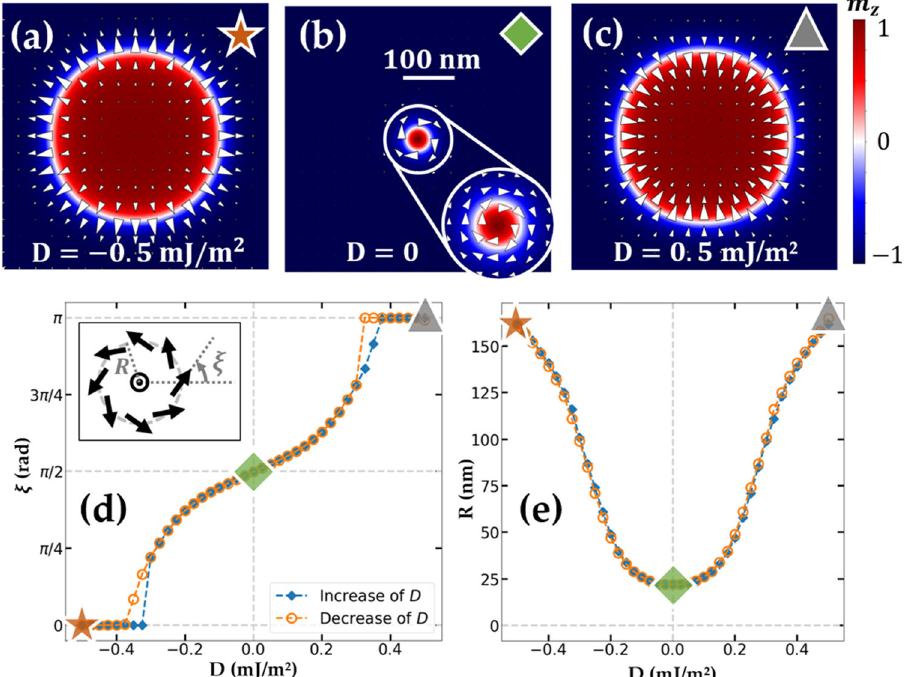
Fig. 4 | Micromagnetic simulations of chirality switch. Simulated stable states show a gradual transition between a CW Néel skyrmion at D = − 0.5mJ/m 2 and c CCW Néelskyrmion at D =0.5 mJ/m 2 via b a stableBloch skyrmion state at D =0. d Angle ξ between the in-plane magnetic moments and the radial direction of the